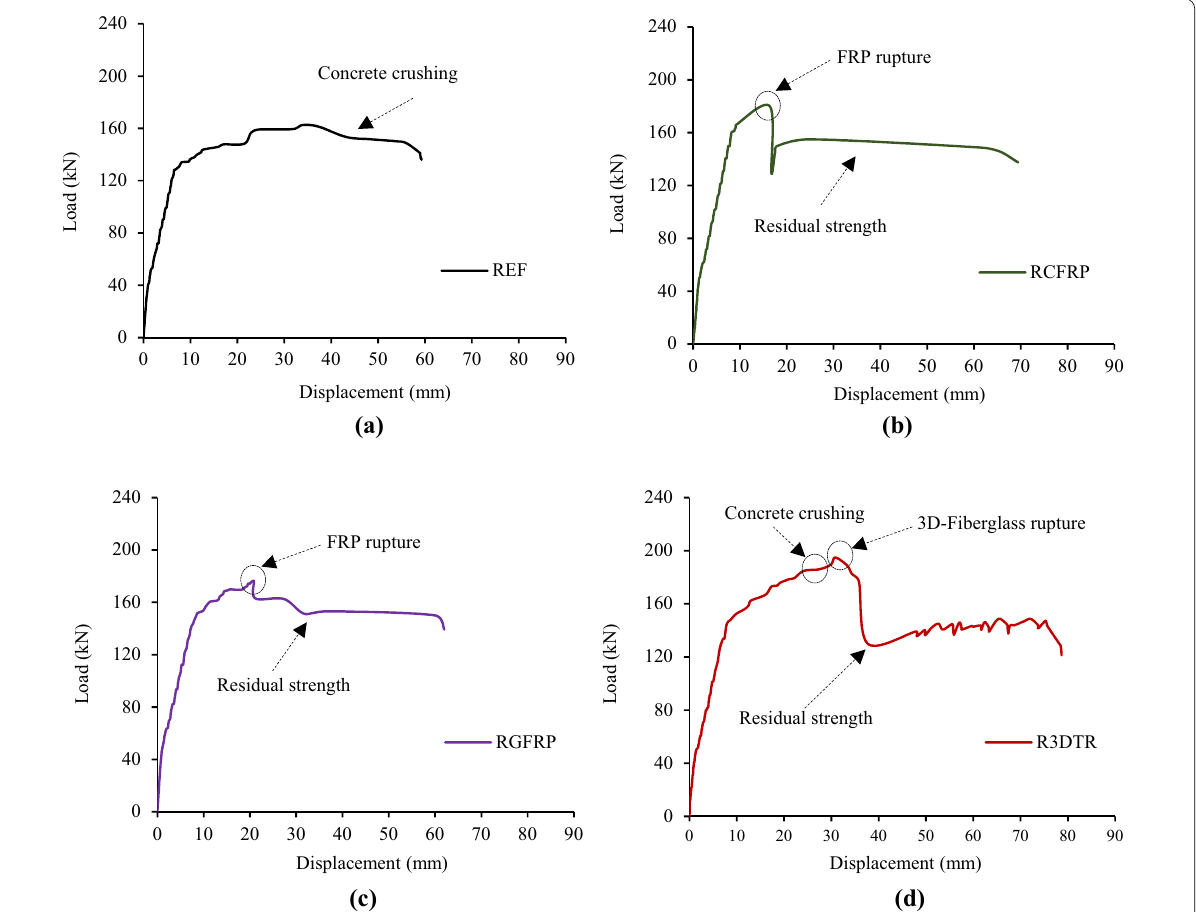
Fig. 8 Load–displacement curves of the tested beams: a REF specimen, b RCFRP specimen, c RGFRP specimen, and d R3DTR specimen.